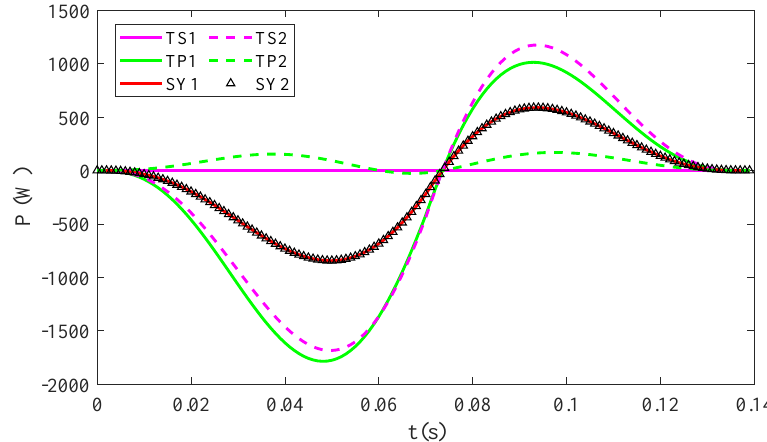
Figure 2. The required power curves of each joint during vertical jumping.